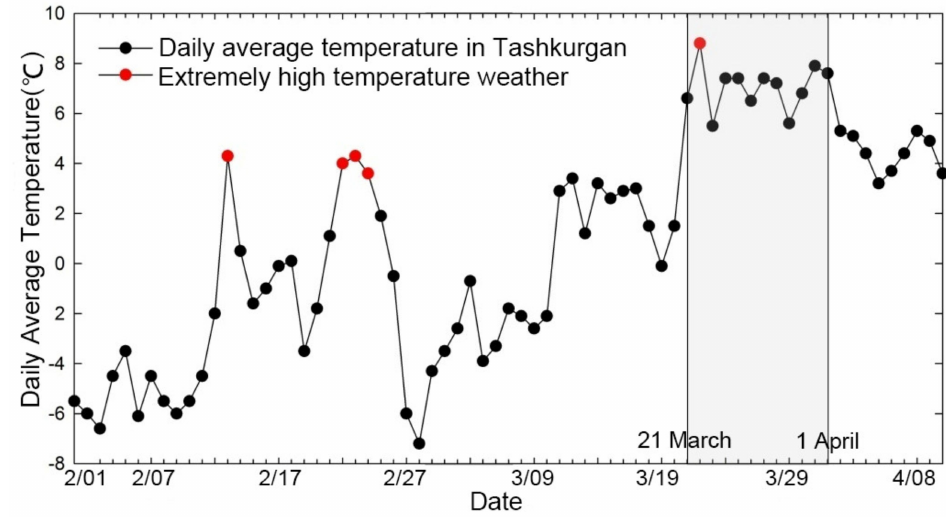
Figure 11. The daily average temperature in Tashkurgan from 2015/2/1 to 2015/4/08 and emphasized the high-temperature period from 21 March to 1